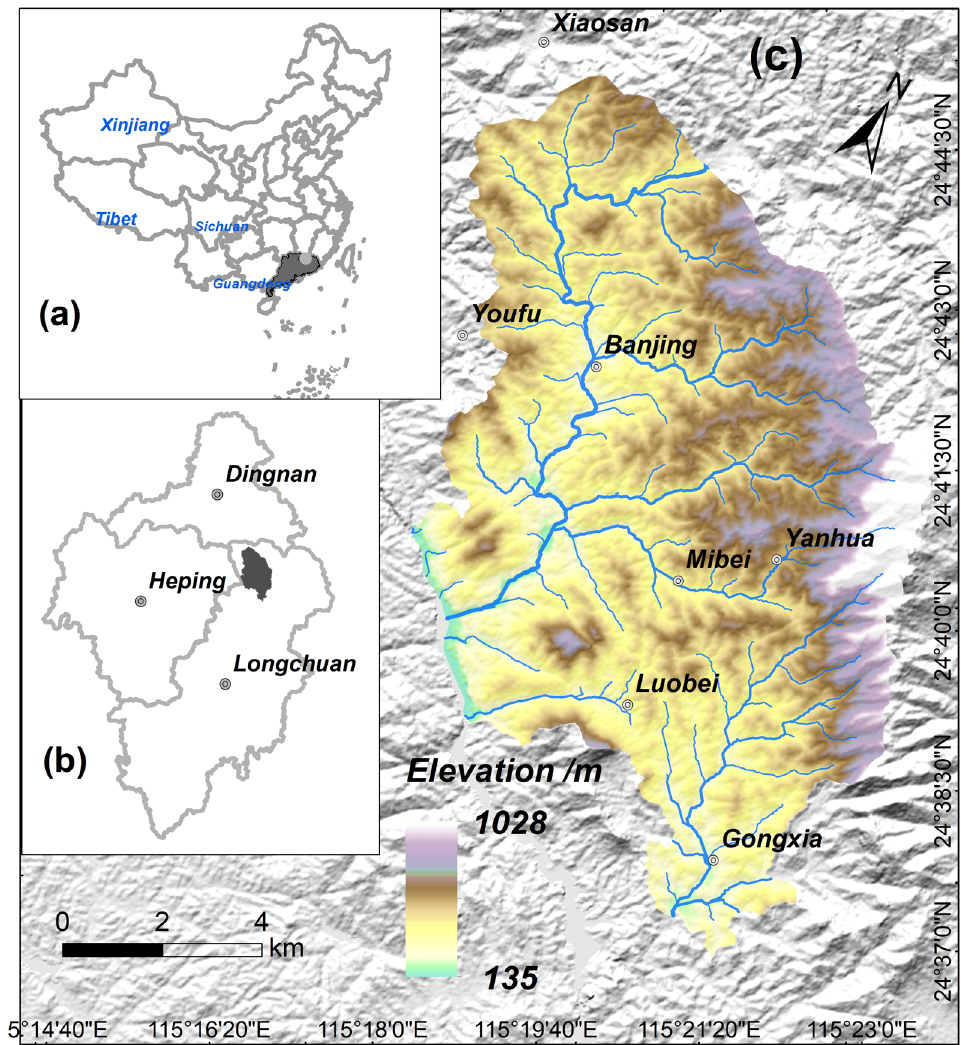
Figure 1. Mapping shows the location and elevation of the study area; ( a ) Guangdong Province; ( b ) location of Longchuan county; ( c ) the elevation and water net distribution of the study area.